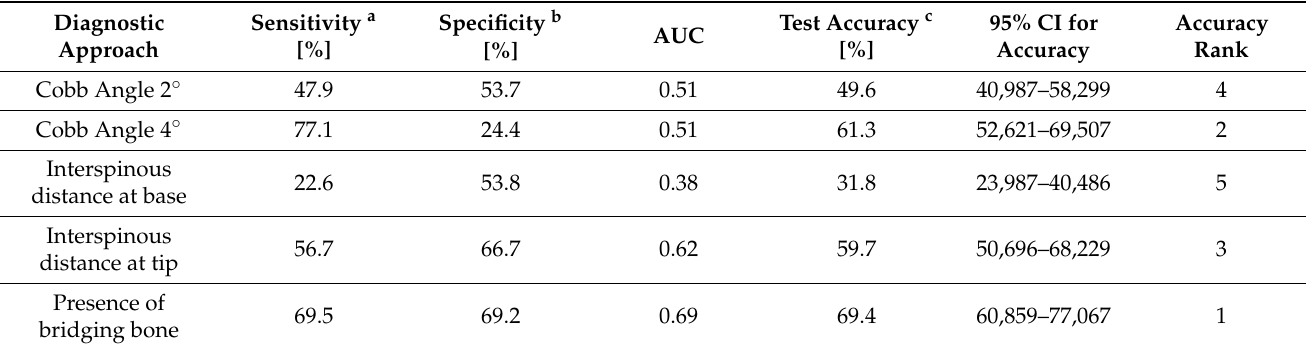
Table 2. Approaches to assessing fusion after 12 months in relation to fusion status assessed in the current